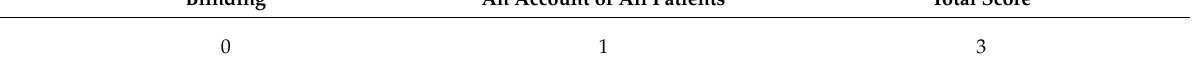
Table 3b. Quality assessment of included studies using the Therapy CA